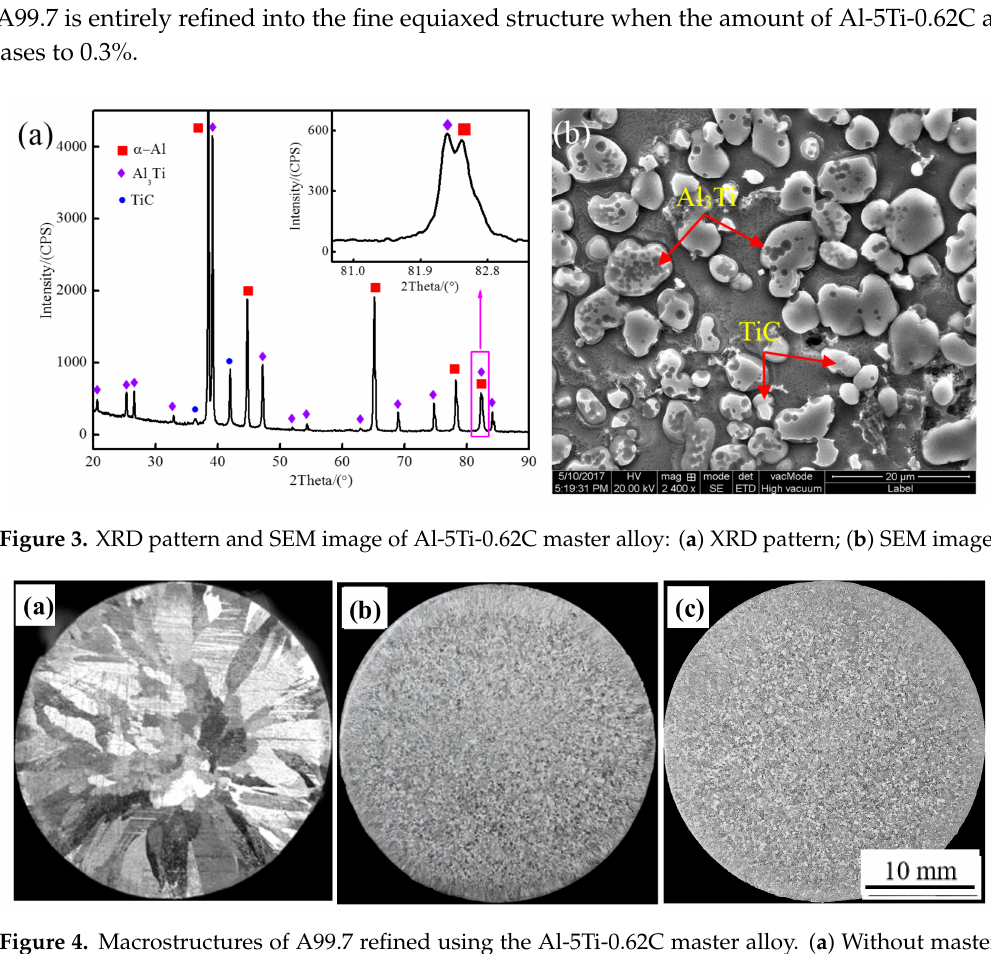
Figure 4. Macrostructures of A99.7 refined using the Al-5Ti-0.62C master alloy. ( a ) Without master alloy; ( b ) 0.2%; ( c )